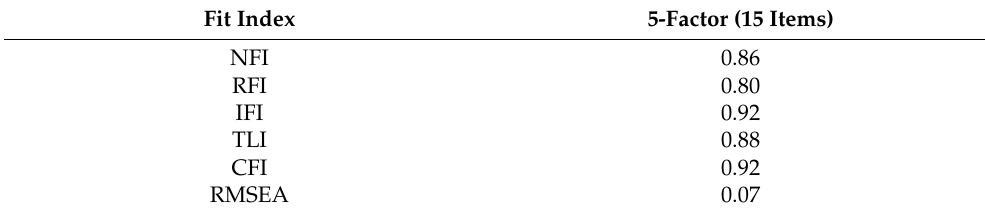
Table 2. Fit indices for the RASI 5-factor